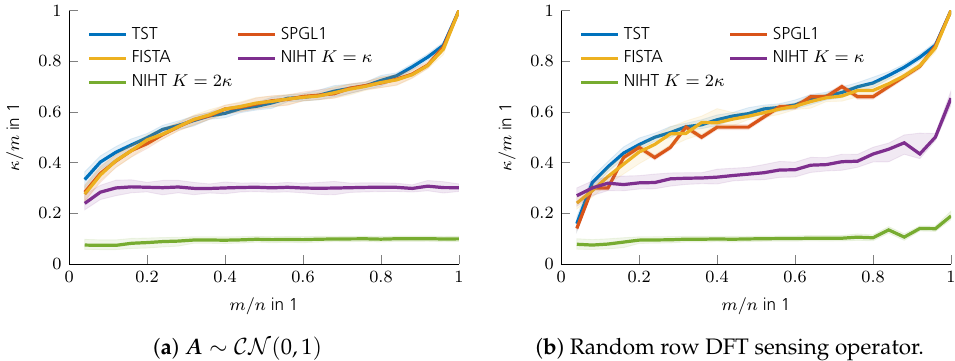
Figure 8. Comparison of reconstruction performances for CSCSA update. Reconstruction success is defined as SRE ≤ −